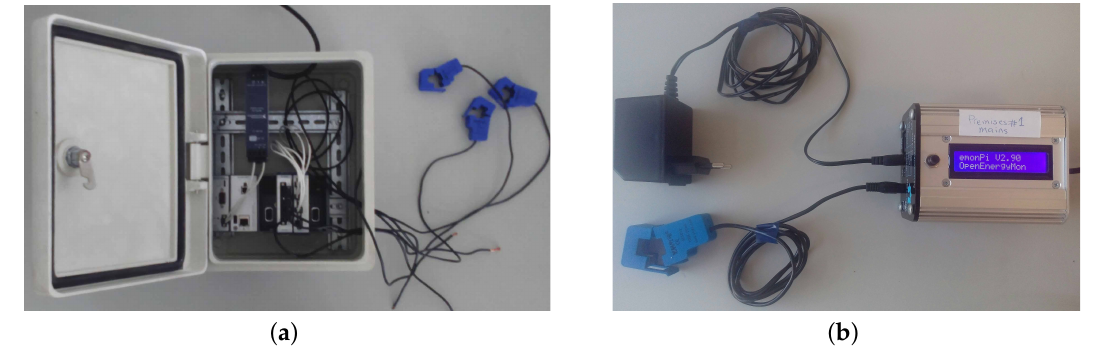
Figure 5. Acquisition systems used in the acquisition campaign of MORED. ( a ) Three-phase IMPEC system; ( b ) emonPi